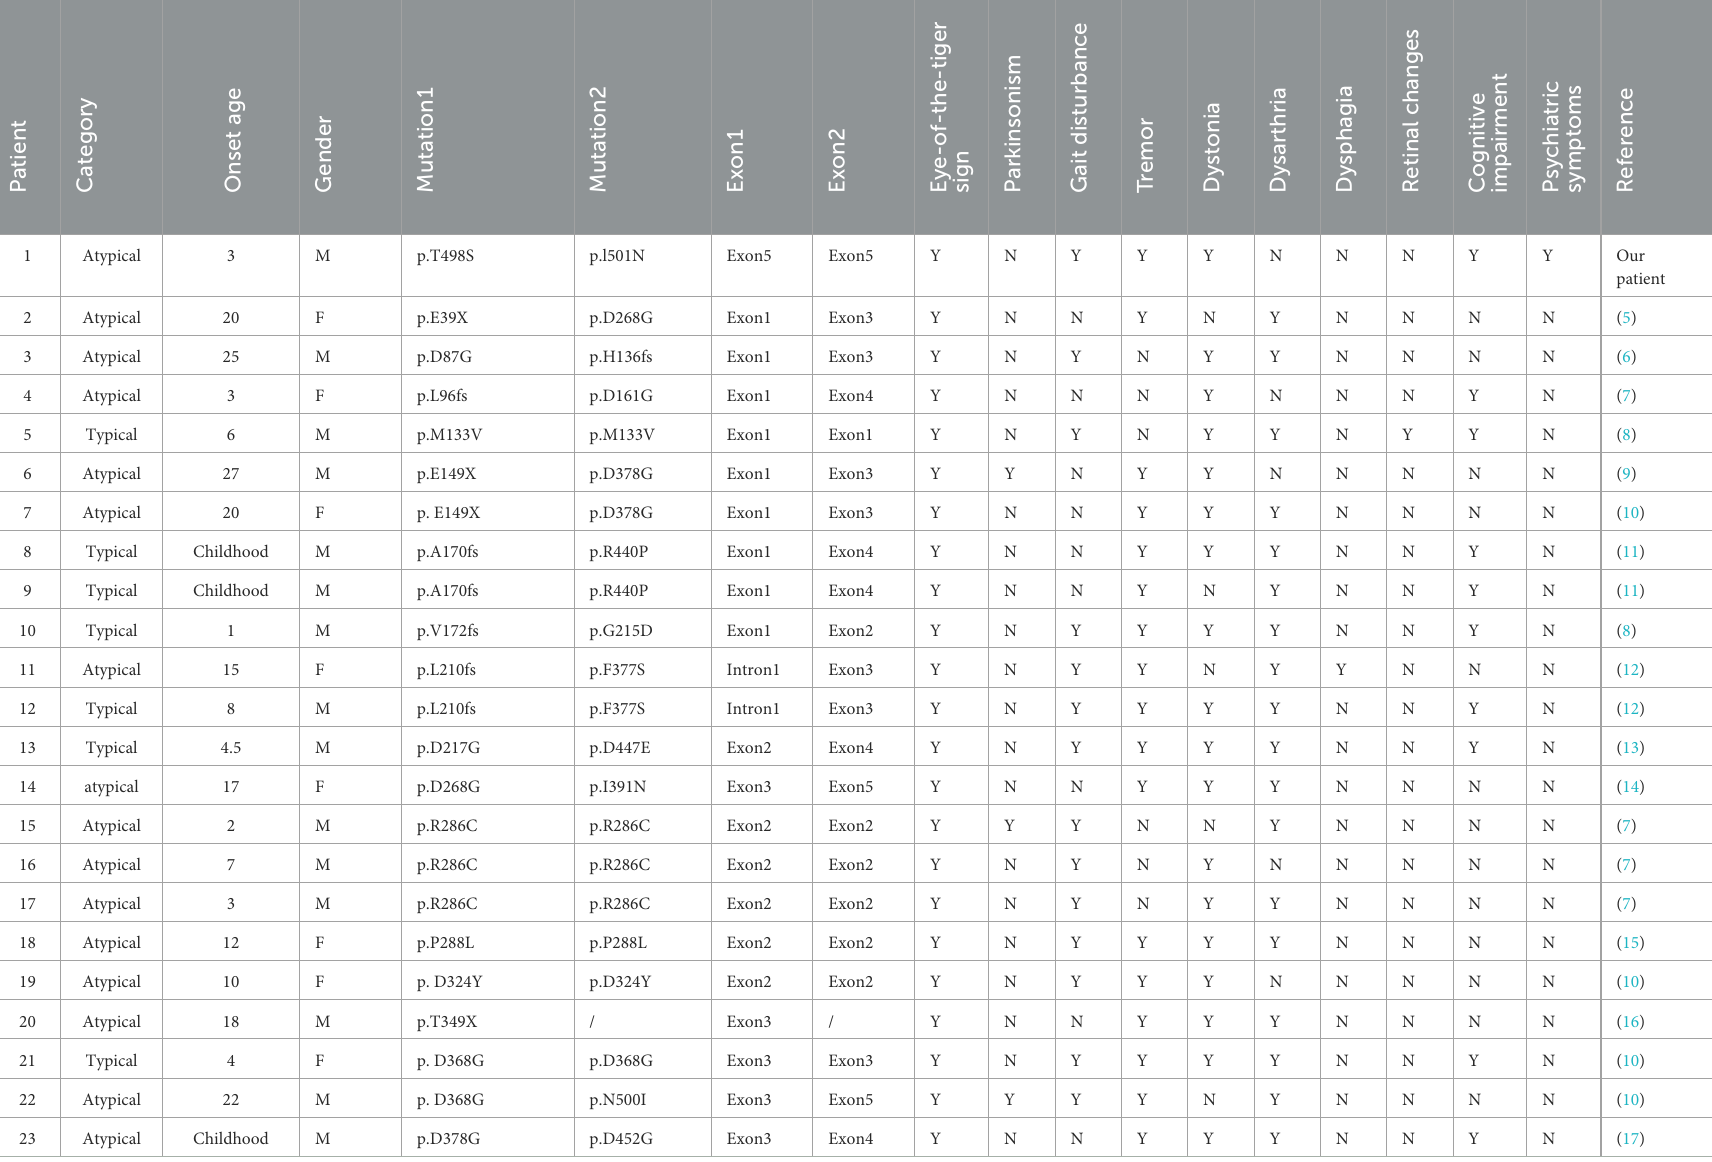
TABLE 1 Clinical, radiological, and genetic characteristics in Chinese patients with